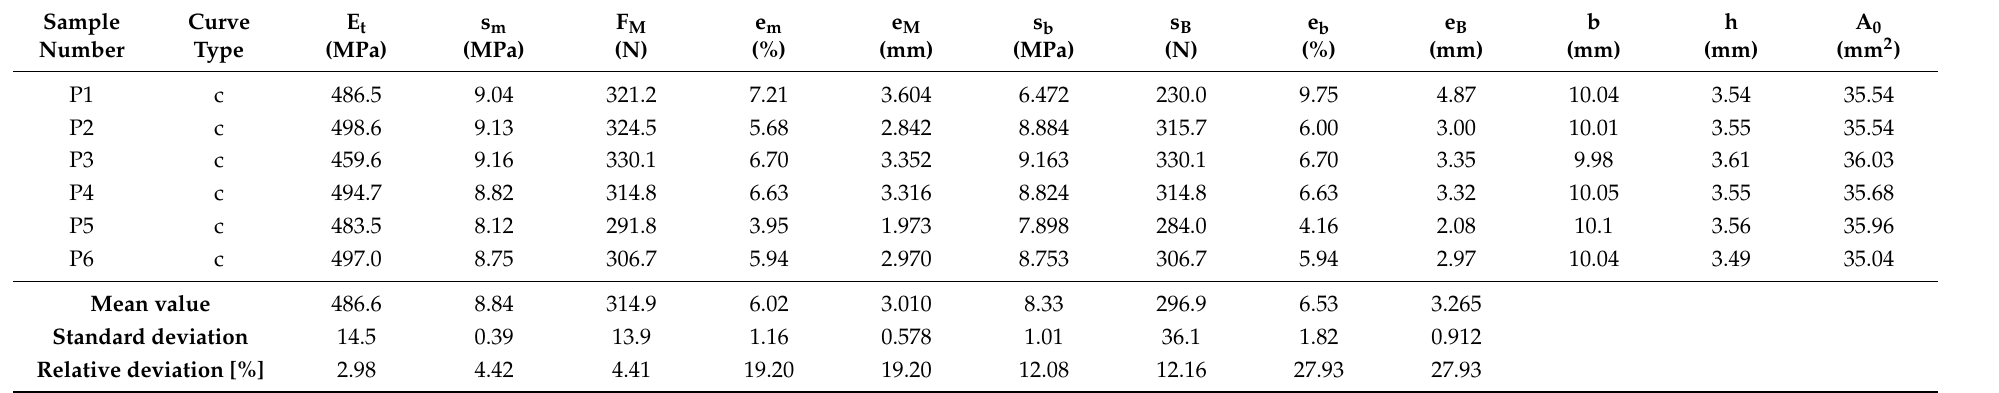
Table A27. Results of the tensile tests of